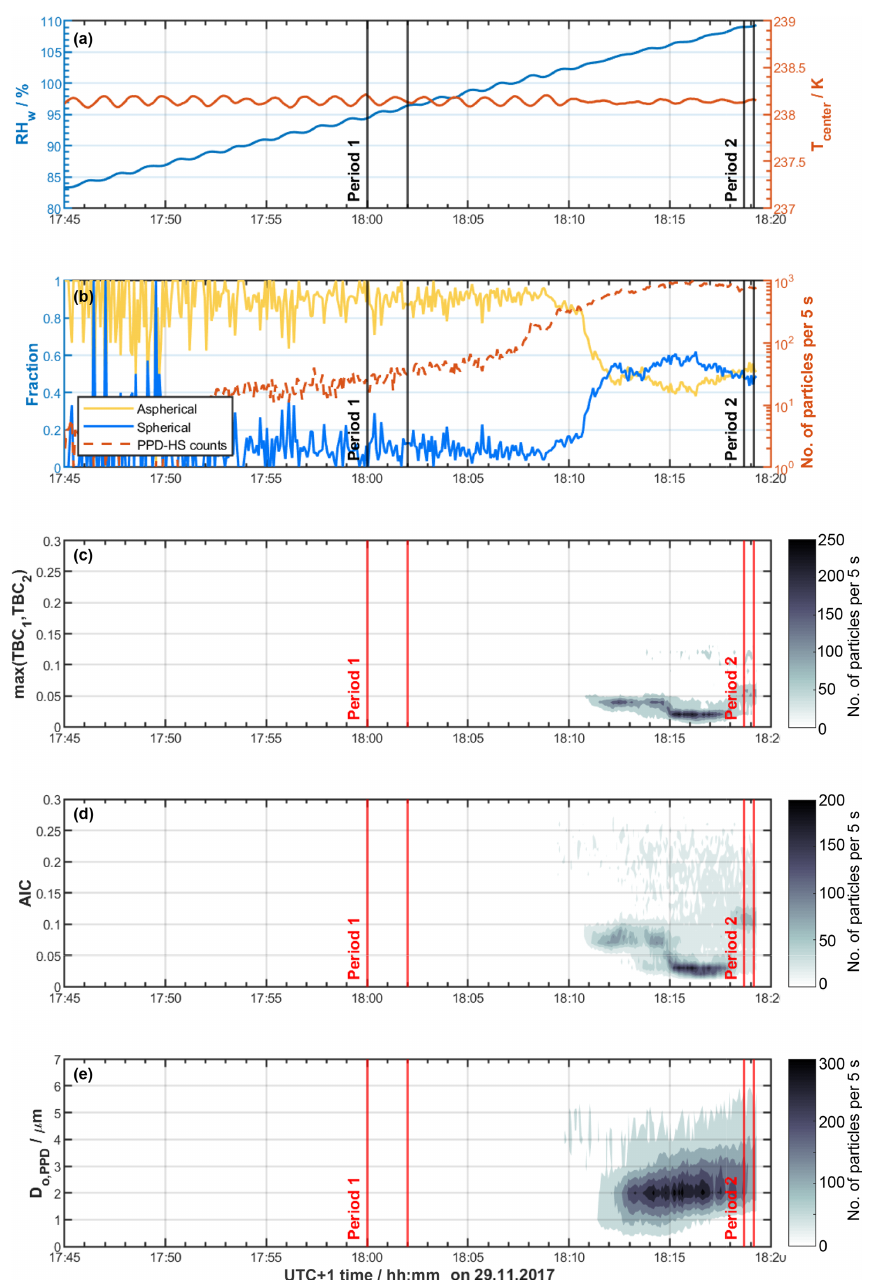
Figure 11. Freezing experiments of d m = 400nm illite NX aerosol using HINC at T = 238K and a residence time τ = 22s. Panels and symbols as in Fig.